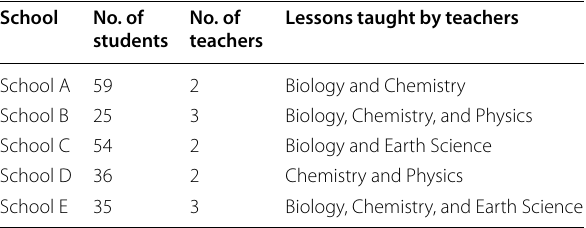
Table 1 Overview of the participants in the